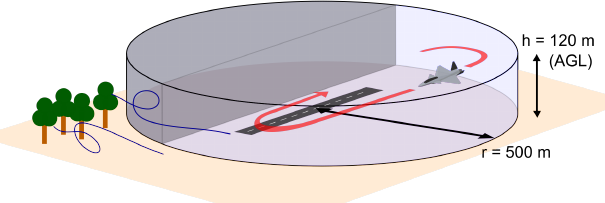
Figure 2. A typical flight within VLOS is a challenging environment for excitation and identification. The short time available and the ground turbulence require special